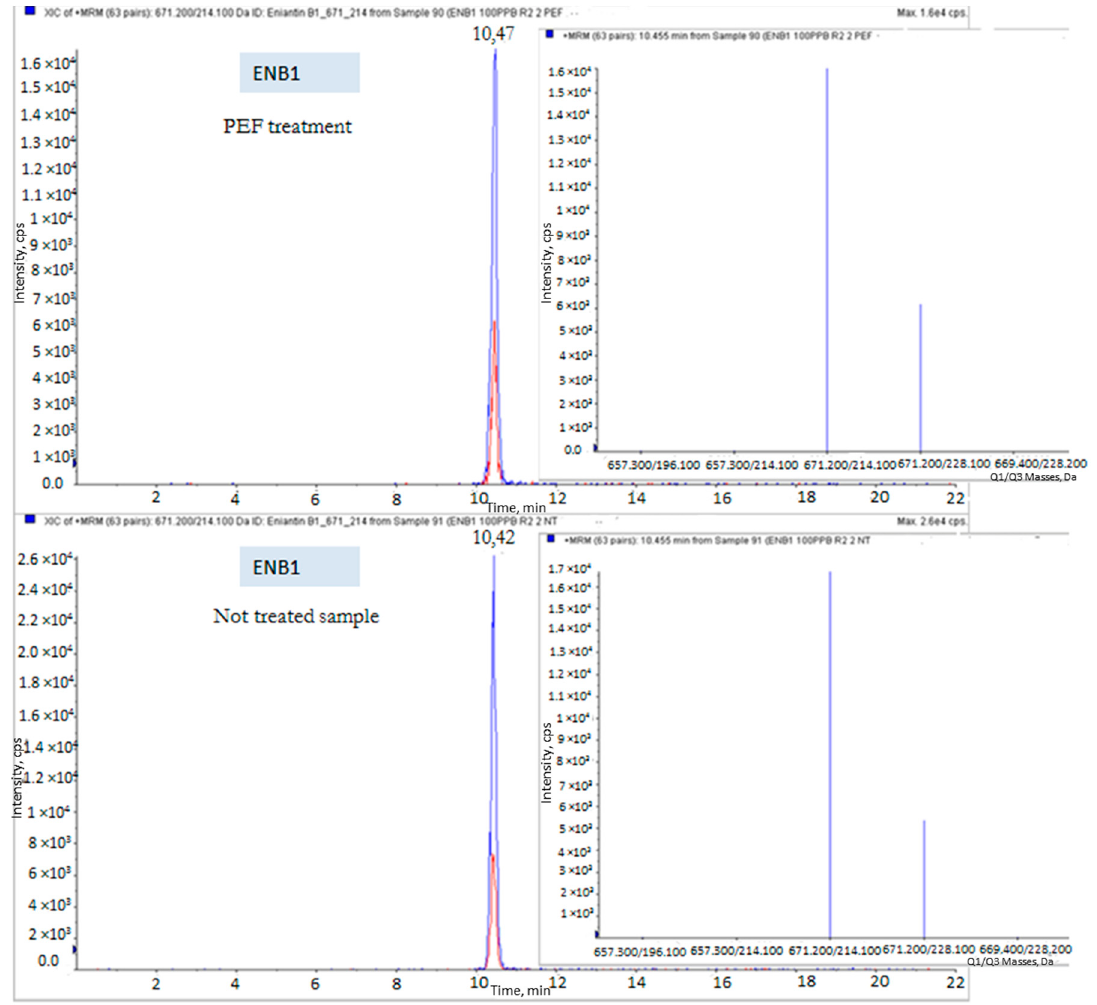
Figure 2. LC-MS/MS-IT chromatogram of juice sample contaminated by enniatin B1 (ENB1) treated Figure 2. LC-MS / MS-IT chromatogram of juice sample contaminated by enniatin B1 (ENB1) treated by by pulsed electric fields (PEF) vs. non-treated. pulsed electric fields (PEF) vs.